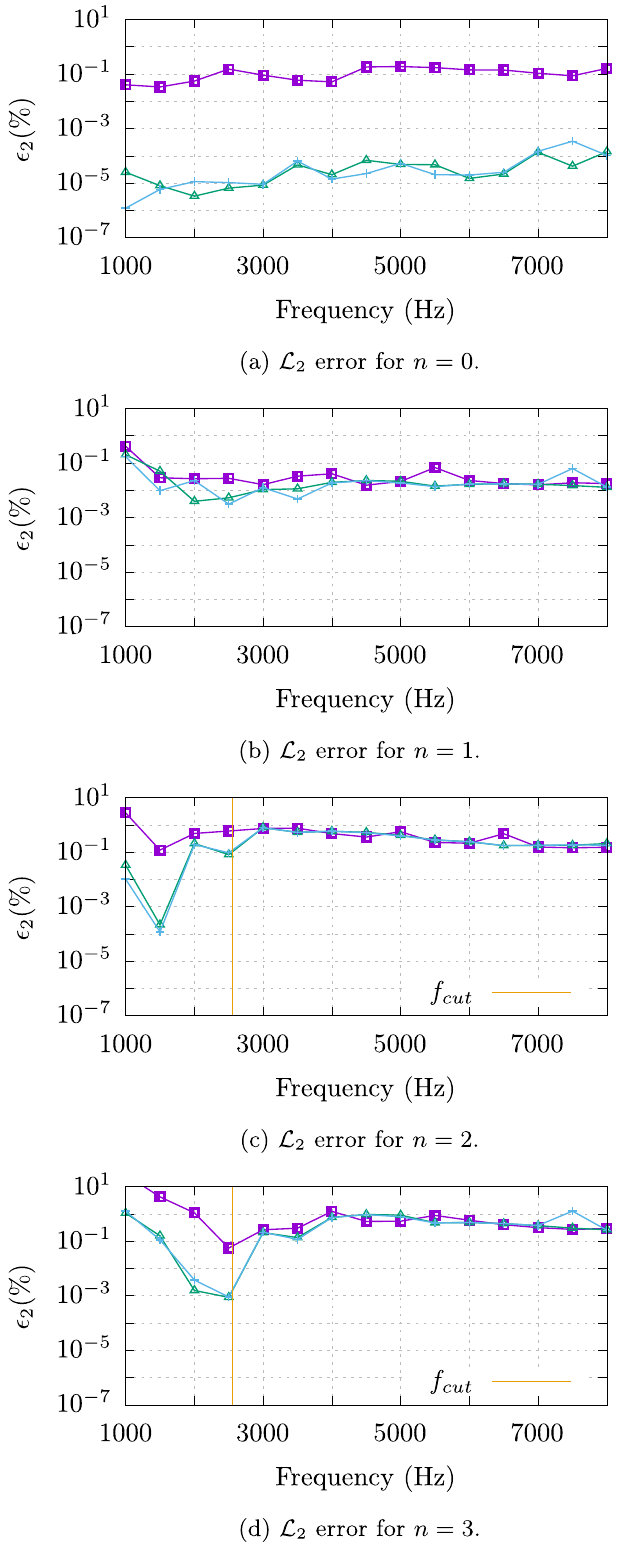
Figure 6. In fl uence of C on the L 2 error for different excitation order n .